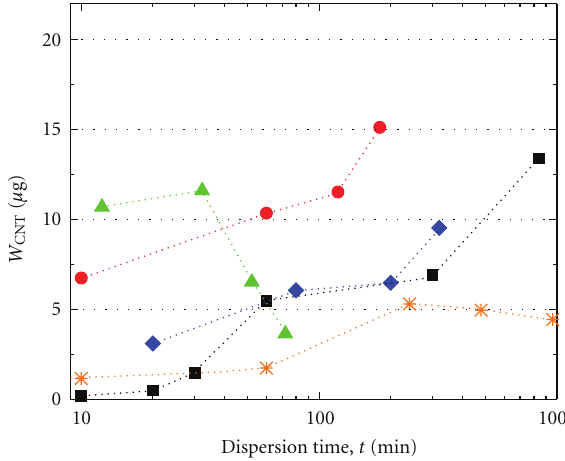
Figure 6: Mass of CNTs in the suspension, W CNT , as a function of sonication time and horn amplitude: 10% ( (cid:2) ), 20% ( (cid:3) ), 40% ( • ), 70% ( (cid:4) ), and bath sonicator ( ∗